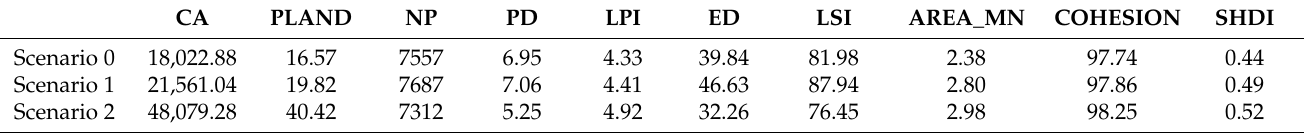
Figure 7. Results of the CA Model Simulation of Green Spaces in Beijing’s Central District in 2035 (Scenario 2). Table 5. Predicted Landscape Metrics Relating to Green Spaces in Beijing’s Central District in